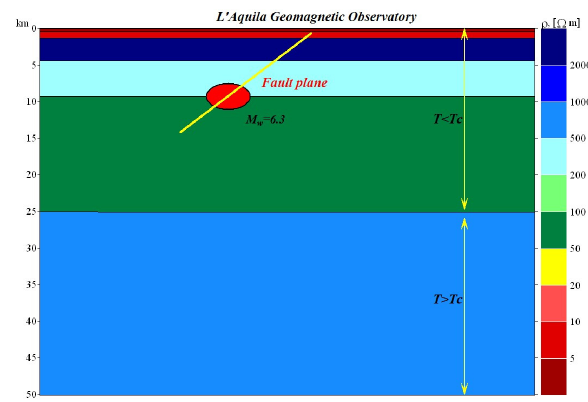
Fig. 4. Local earth resistivity structure around L'Aquila Geomagnetic Observatory